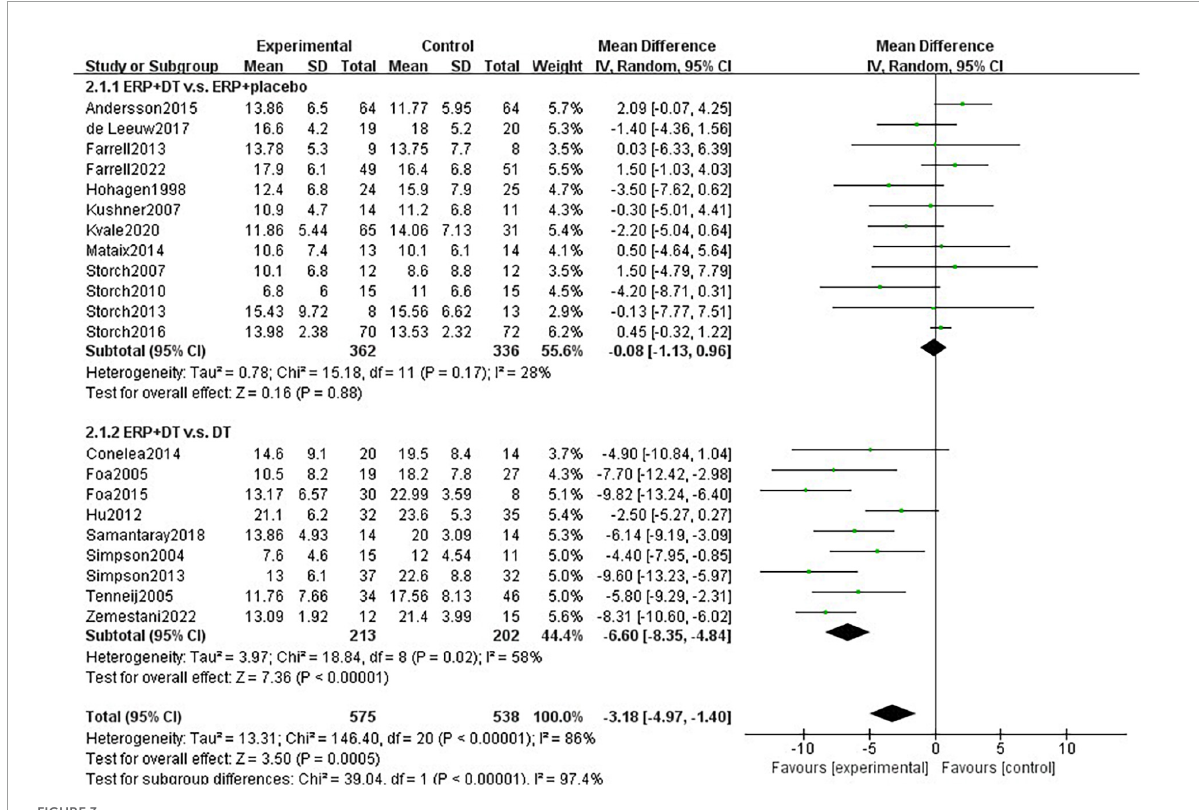
FIGURE3 Subgroup analysis of drug type for the effect of combination therapy on the intervention of obsessive-compulsive symptoms in patients with